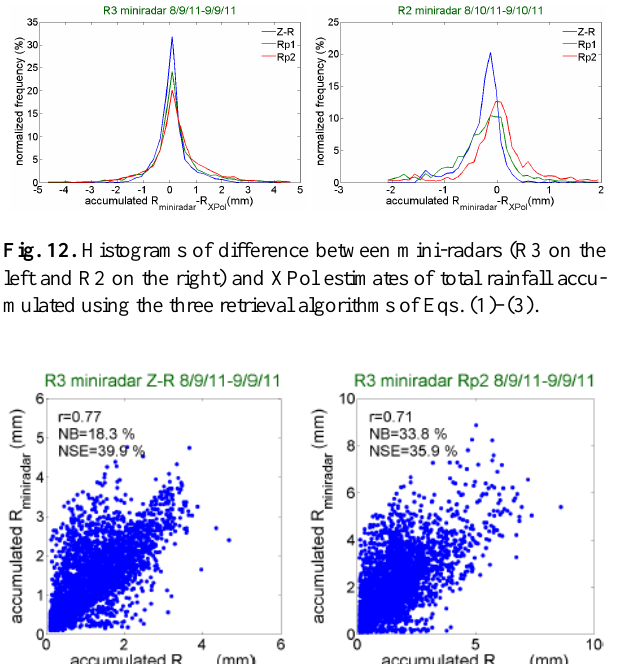
5 Figure 13. Scatterplot of accumulated rain from XPol and R3 mini-radar, using two different rain estimation algorithms (Z-R on the left panel, Rp2 on the right panel).